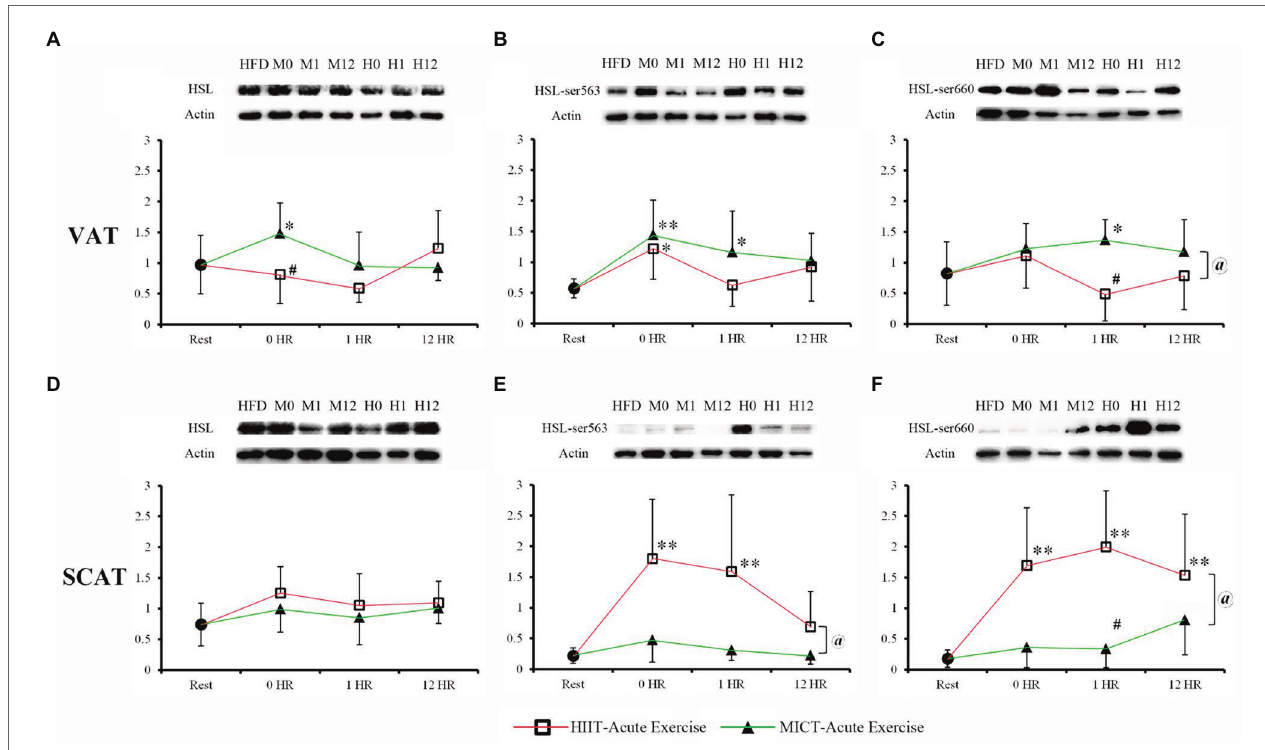
FIGURE 2 | Hormone sensitive lipase (HSL) protein expression and phosphorylation of visceral WAT (VAT; A-C ) and SACT (D-F) after one-time acute exercise. High-fat diet (HFD) or rest: HFD-Rest group, set as baseline without training; M0, M1, and M12: moderate-intensity continuous training (MICT)-0HR, -1HR, and -12HR; H0, H1, and H2: high-intensity interval training (HIIT)-0HR, -1HR, and -12HR; * p < 0.05 vs. rest; ** p < 0.01 vs. rest; # p < 0.05 HIIT vs. MICT; and @ Main effect of the training type (MICT vs. HIIT) p < 0.05, when no significant interaction between two factors (training type and time point) was found. Values of p between HFD- Rest and acute exercise groups were calculated by one-way ANOVA, and values of p between MICT and HIIT were calculated by 2 × 3 two-way ANOVA. Bands shown are representative for overall